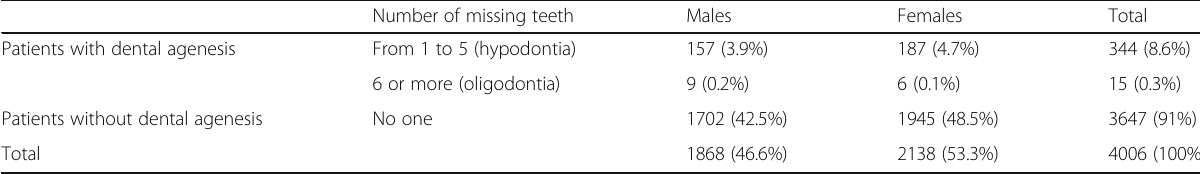
Table 1 Distribution of the patients by gender and number of missing teeth